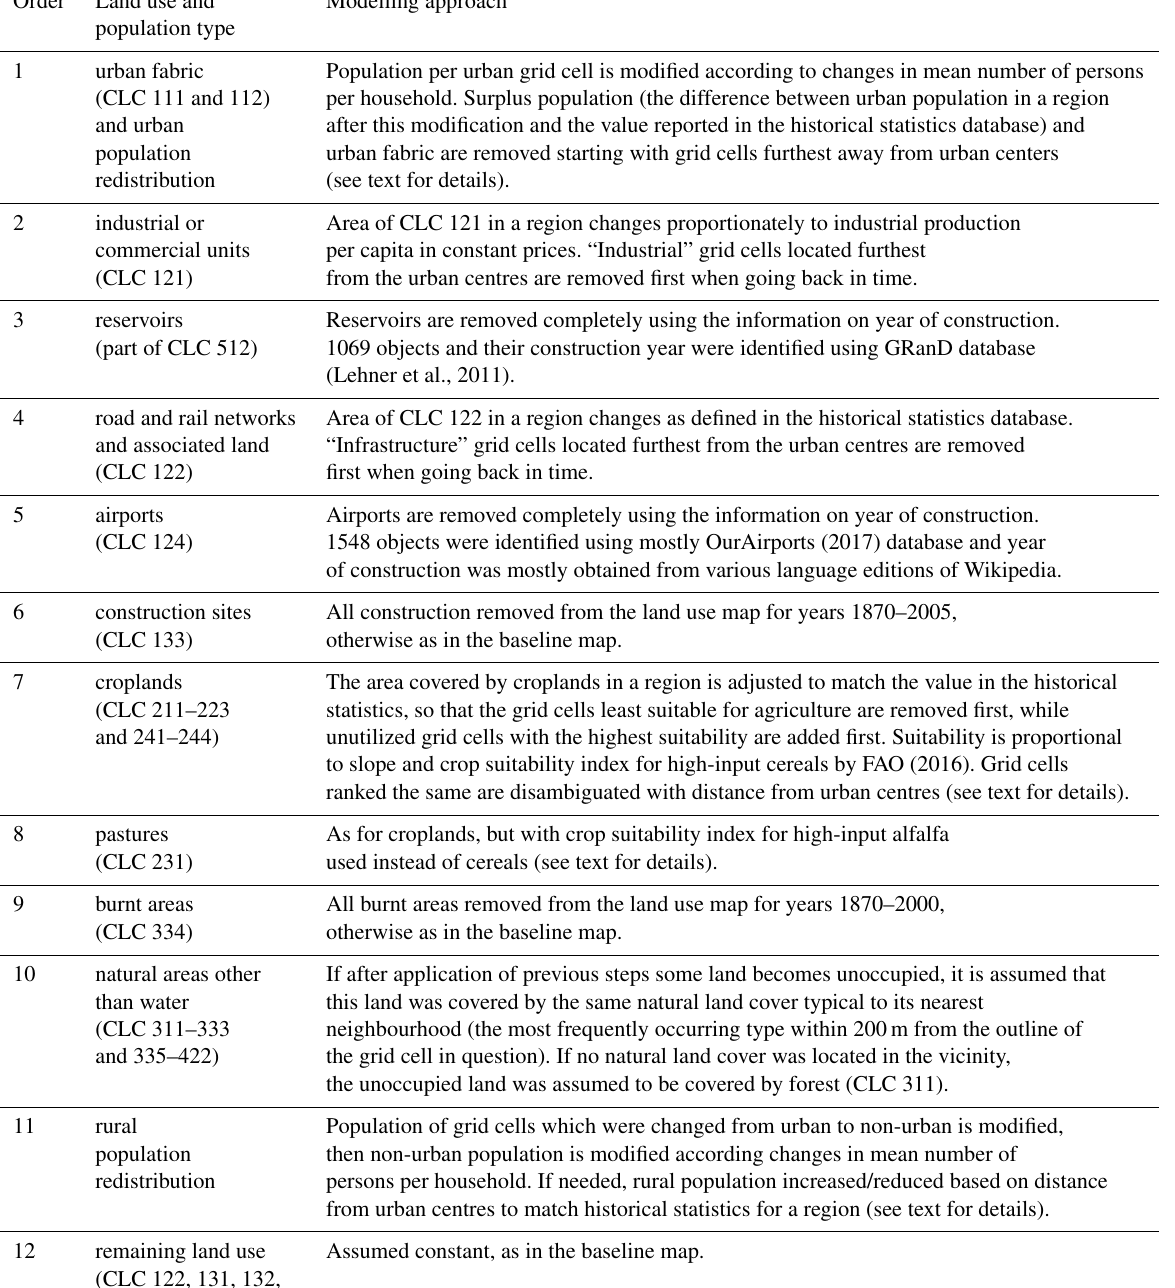
Table 2. Summary of historical land use and population modelling approaches, by CORINE Land Cover classes (see Fig. S3). The number in first column indicates the order in which the modification of land use and population was